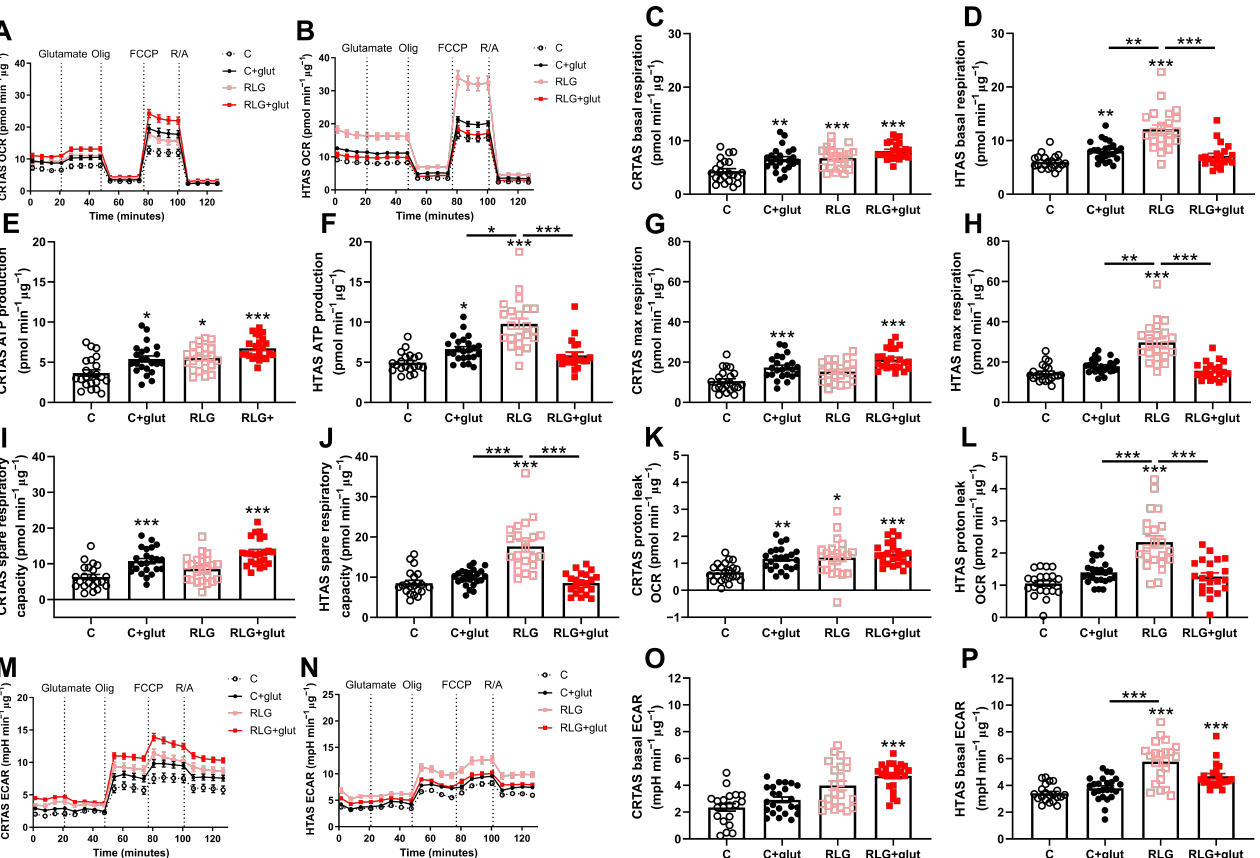
Figure 5. Recurrent low glucose-induced metabolic adaptations attenuated with co-treatment of glutamate in hypothalamic but not cortical astrocytes. Concurrent glutamate treatment exacerbated the effects of RLG in CRTAS on metabolism but ameliorated the effects in HTAS. After control, control plus glutamate (C + glut), RLG or RLG plus glutamate (RLG + glut) treatment, cells underwent a mitochondrial stress test (CRTAS n = 49, 52, 46, 57, respectively, across three separate assays; HTAS n = 21, 24, 22, 21, respectively, across two separate assays). OCR of CRTAS ( A ) and HTAS ( B ). Basal mitochondrial respiration of CRTAS ( C ) and HTAS ( D ) calculated as non-mitochondrial OCR subtracted from basal OCR. ATP-production associated OCR of CRTAS ( E ) and HTAS ( F ), calculated as the difference between basal OCR and ATP-synthase inhibited OCR. Maximal respiratory OCR, induced by the mitochondrial membrane uncoupler FCCP, of CRTAS ( G ) and HTAS ( H ). Spare respiratory capacity of CRTAS ( I ) and HTAS ( J ), calculated as the difference between maximal respiration and basal respiration. Proton leak of CRTAS ( K ) and HTAS ( L ), calculated as the difference between ATP-associated OCR and non-mitochondrial respiration. ECAR of CRTAS ( M ) and HTAS ( N ) during the mitochondrial stress test. Basal ECAR of CRTAS ( O ) and HTAS ( P ). Error bars represent standard error of the mean. * p < 0.01; ** p < 0.01; *** p < 0.001. Normally distributed data were analysed using one-way ANOVAs with post hoc Tukey’s multiple comparisons test. Abnormally distributed data were analysed using Kruskal–Wallis test with post hoc Dunn’s multiple comparisons test. Open circles, closed circles, pink squares and red squares denote control, C + glut, RLG, and RLG + glut,